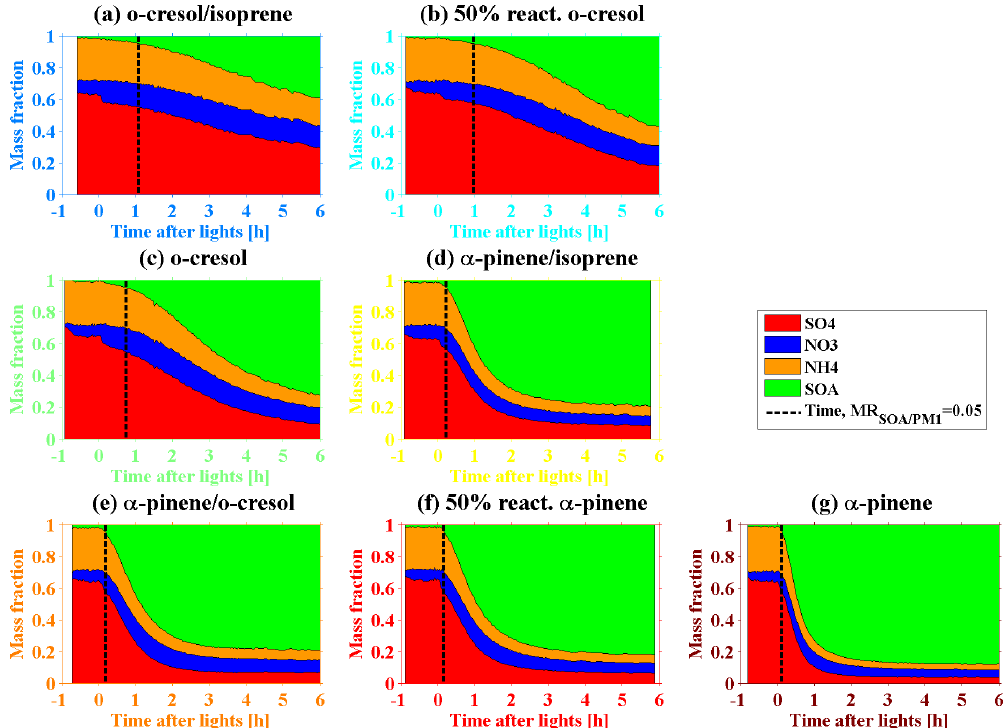
Figure 3. Summary of mass fraction of chemical species (SO 4 , NO 3 , NH 4 , and SOA) in bulk NR–PM 1 measured by HR-ToF-AMS in the photochemistry of various VOC systems on deliquescent ammonium sulfate seed. The black dashed line represents the defined time at which the SOA mass fraction is